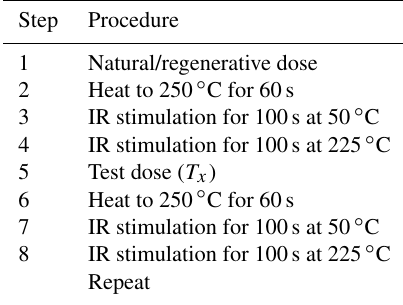
Table B1. Modified post-IR IRSL 225 ◦ C (Buylaert et al., 2009) protocol applied to measure the luminescence signals from